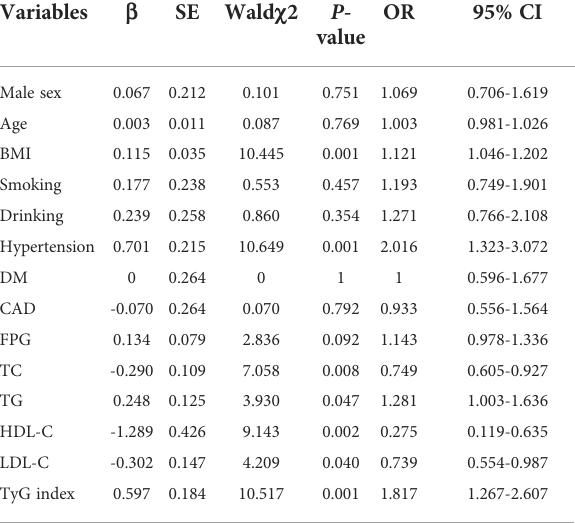
TABLE 2 Univariate logistic regression analysis of risk factors for AF in all